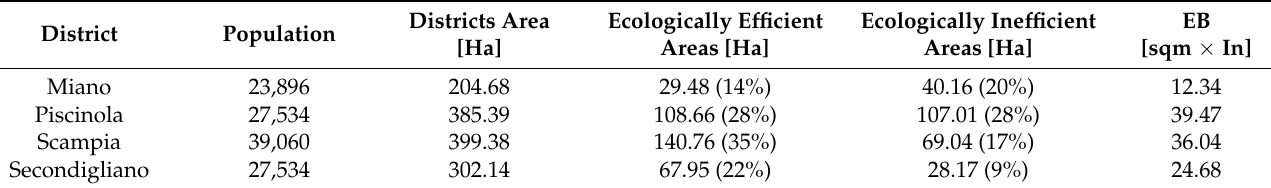
Table 3. Statistics of districts by ecological efficiency.